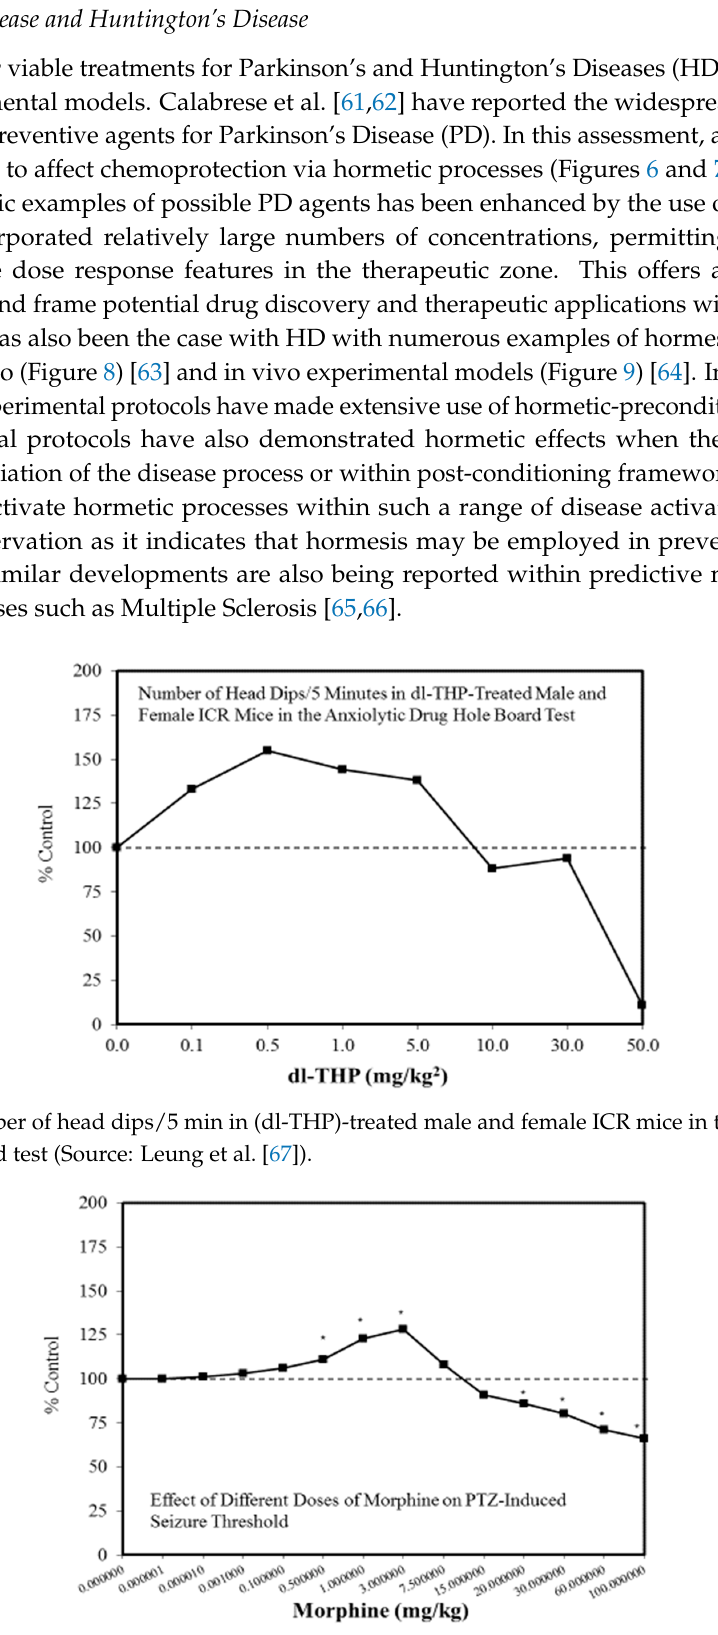
Figure 3. Effect of different doses of morphine on pentylenetetrazole (PTZ)-induced seizure threshold (Source: Honar et al. [68]).